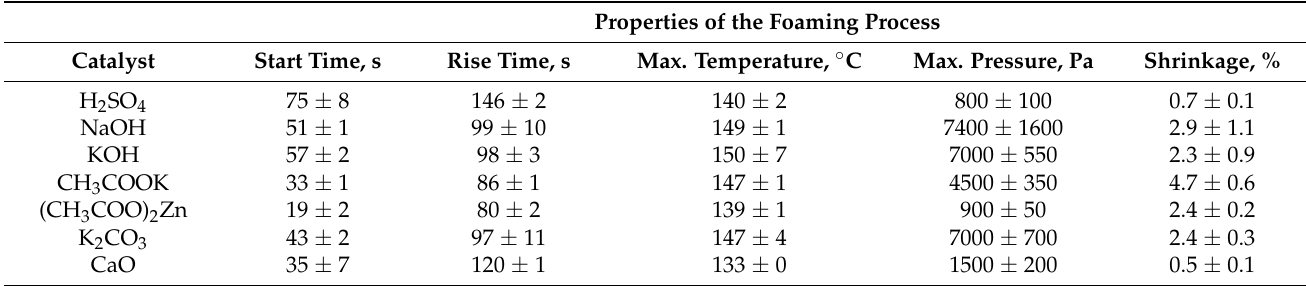
Table 4. The most important properties of the foaming process of polyurethane materials. Properties of the Foaming